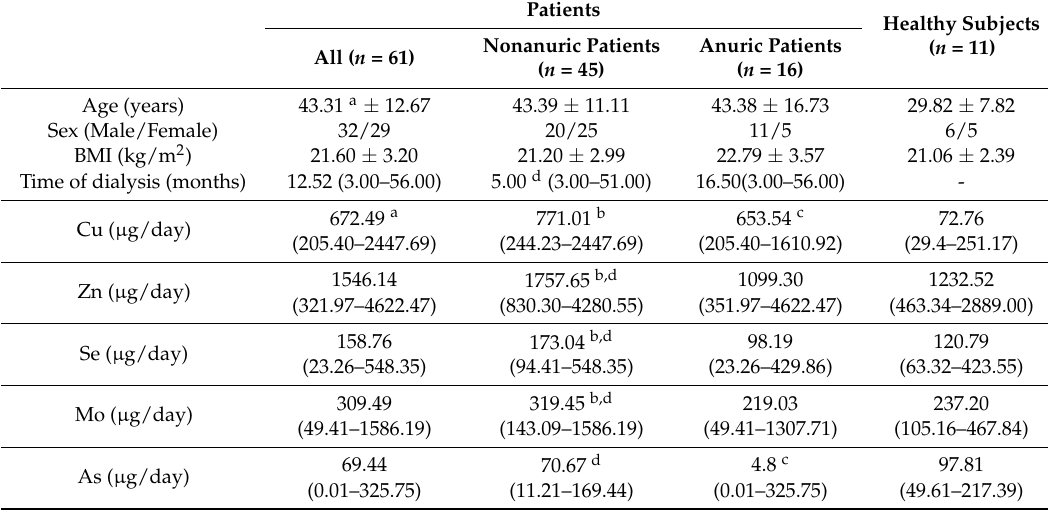
Table 2. Comparison of daily trace element losses between patients and healthy